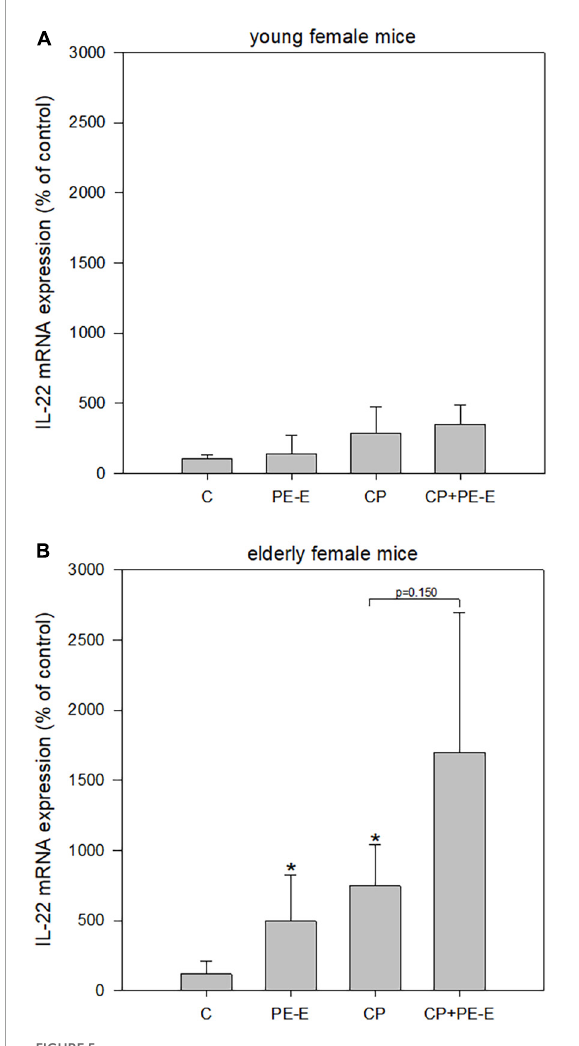
FIGURE5 mRNA expression levels of IL-22 in gut tissue of (A) young and (B) elderly female mice. C, negative control group treated with water for 14 days; PE-E, Pleurotus eryngii control group treated with 600 mg/kg P. eryngii mushroom extract for 14 days; CP, positive control group treated with water for 14 days and 80 mg/kg cyclophosphamide the 14th day; CP+PE-E, administration of 600 mg/kg P. eryngii mushroom extract for 14 days and 80 mg/kg cyclophosphamide the 14th day. All values are expressed as the mean ± SD of six mice in each group. * p < 0.05 compared to control (water) ( t